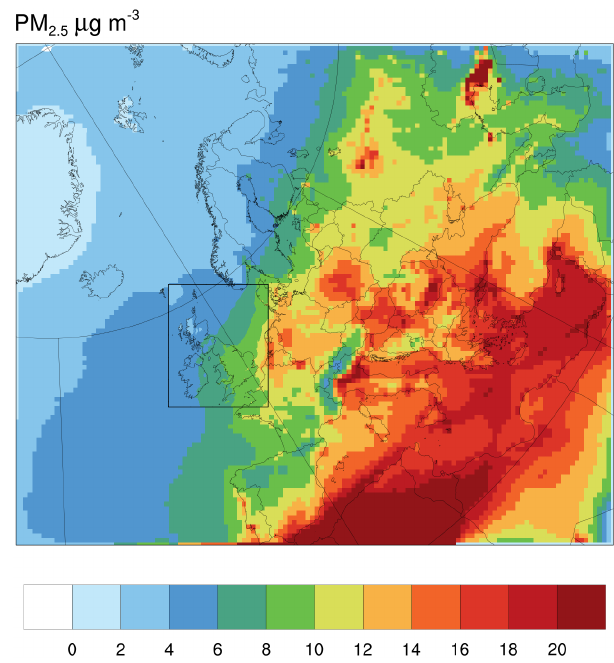
Figure 1. 2010 EMEP4UK annual-average surface concentrations of PM 2 . 5 (µgm − 3 ) at 50km × 50km horizontal resolution for the European model domain, and at 5km × 5km horizontal resolution for the nested Great Britain and Ireland domain (black